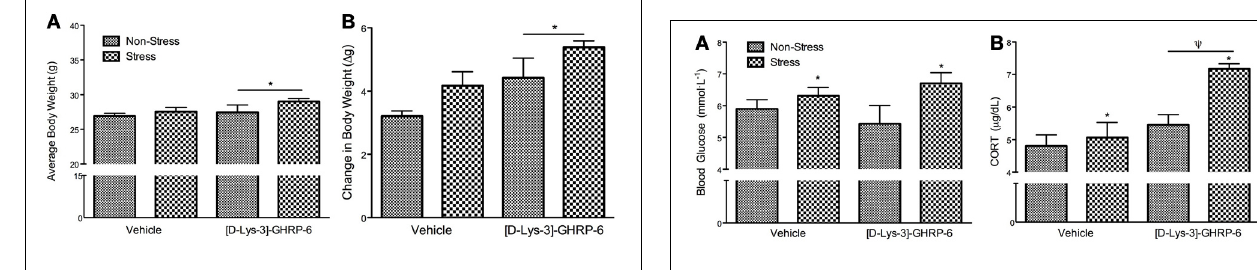
FIGURE 4 | (A) Plasma blood glucose levels and (B) plasma corticosterone levels in trunk blood collected at the time of sacrifice. All values are expressed as mean ± s.e.m. ∗ p < 0 . 05 relative to non-stressed animals; ψ p < 0 . 05 relative to vehicle treated